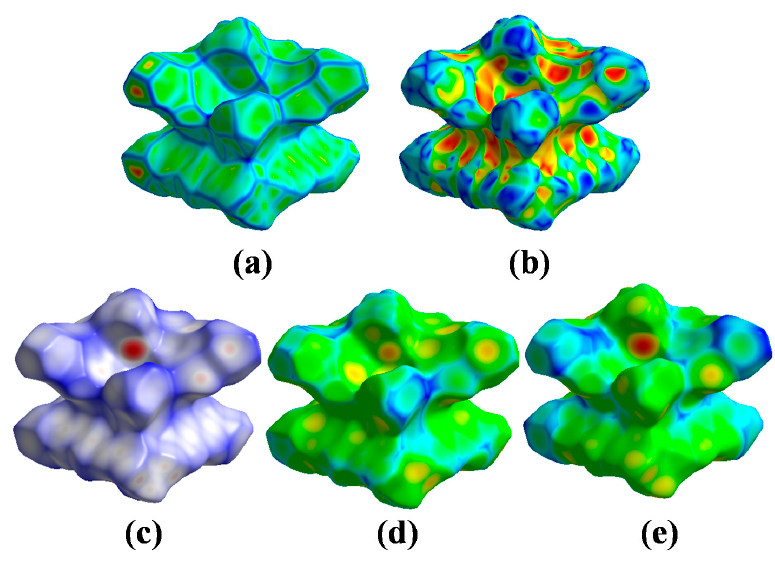
Figure 7. Hirshfeld surface analysis of the Co(II) complex: ( a ) Curvedness; ( b ) Shape-Index; ( c ) d norm ; ( d ) d e ; ( e ) d i .